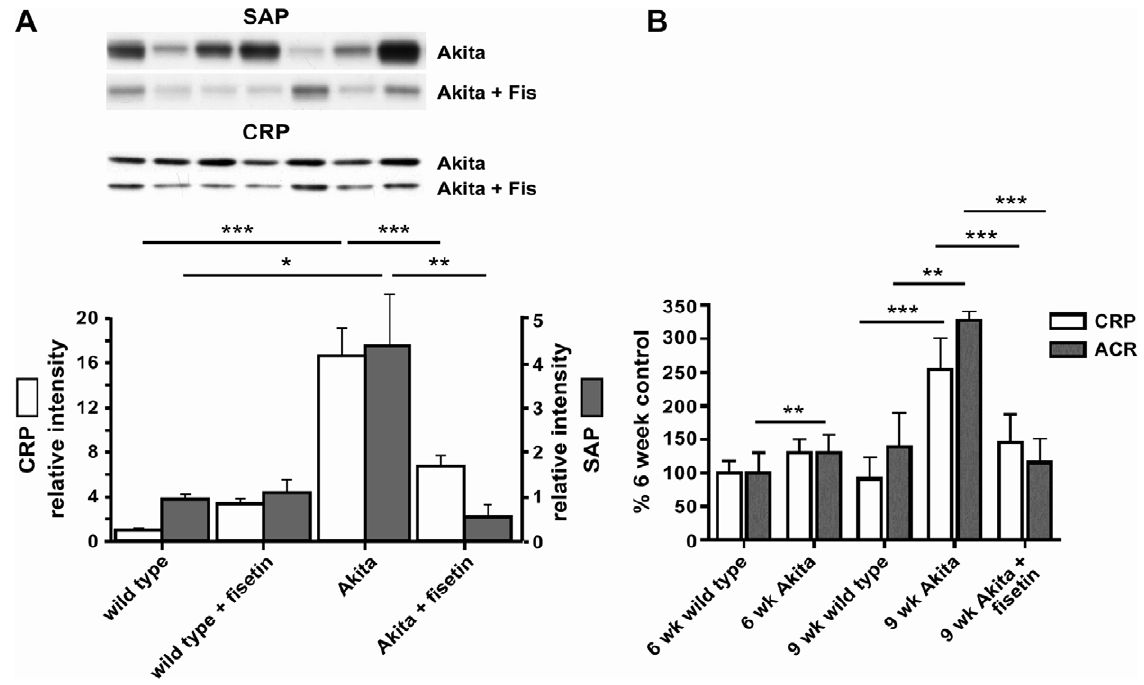
Figure 4. Fisetin reduces markers of inflammation in Akita mice. (A) Male Akita mice were fed control diet or fisetin (0.05%) diet for 18 weeks beginning at 6 weeks of age. C-reactive protein (CRP) and serum amyloid P (SAP) were measured in plasma by Western blotting. Fisetin reduced plasma CRP and SAP levels in the Akita mice to nearly the levels in the control mice. All data are mean 6 SD of n =5–7/group. ***( p , 0.001) indicates significantly different from wild type or Akita alone as determined by ANOVA followed by Tukey’s post test. (B) Age dependent increases in plasma CRP and urine albumin/creatinine ratio (ACR). Male Akita mice were first tested at 6 weeks of age and then fed control diet or fisetin (0.05%) for 3 weeks prior to re-testing. C-reactive protein (CRP) was measured in plasma by Western blotting. The albumin/creatinine ratio (ACR) in the urine was determined using ELISAs. All data are mean 6 SD of n =8–10/group. **( p , 0.01 - 6 week) indicates significantly different from wild type as determined by t-test. **( p , 0.01) and ***( p , 0.001) indicate significantly different from wild type or Akita alone as determined by ANOVA followed